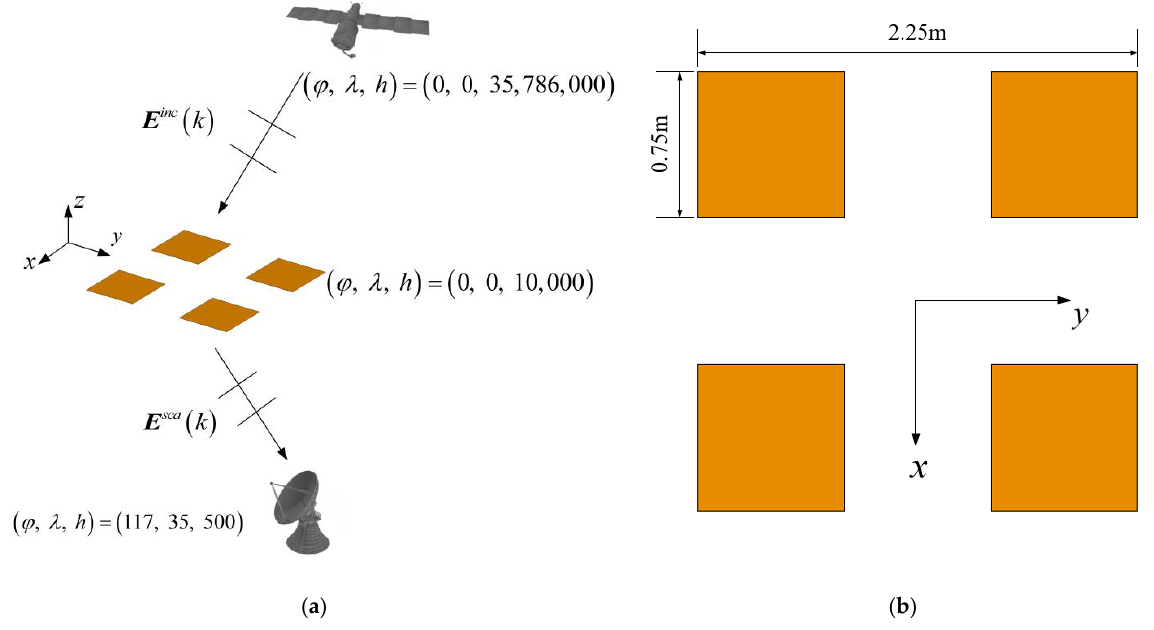
Figure 4. Illustration of the passive bistatic radar system based on a non-cooperative satellite-borne illuminator. ( a ) Geometry of the patch array. ( b ) The model size of the patch array.